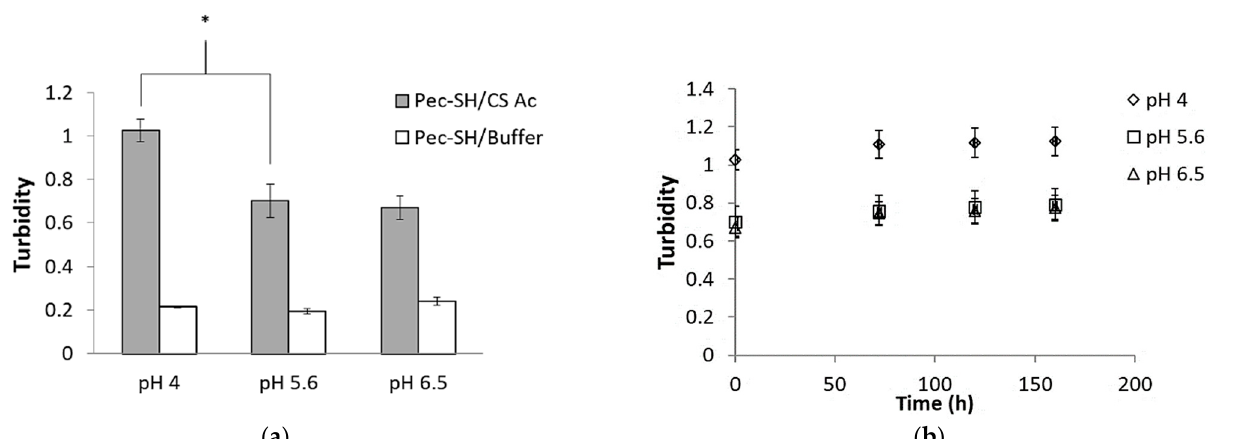
Figure 2. Turbidity measurements of hydrogels prepared at different pH values. ( a ) Immediately after mixing and casting. ( b ) Change with time. The bars represent the standard error of the mean, n = 3. (*) refers to a statistically significant difference at p < 0.05.